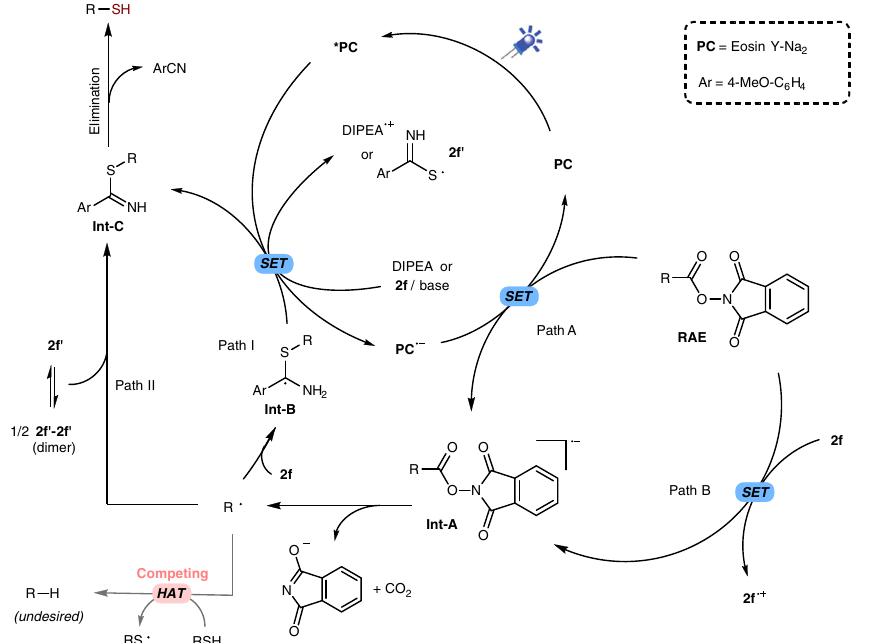
Fig. 4 Reaction pathways. A mechanistic proposal for the decarboxylative thiolation of redox-active esters (RAEs) to free thiols. SET single electron transfer, HAT hydrogen atom